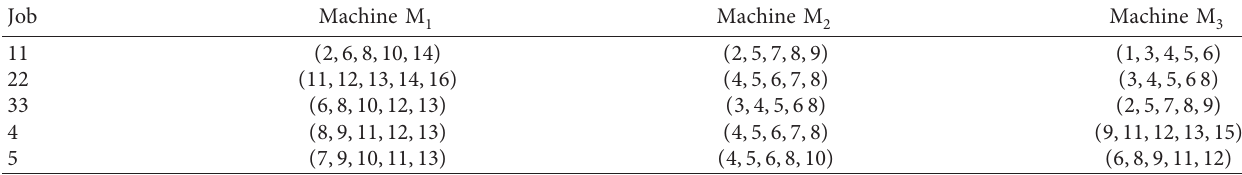
� ( a , a ,a ,a , a ) . P 1 2 3 4 5